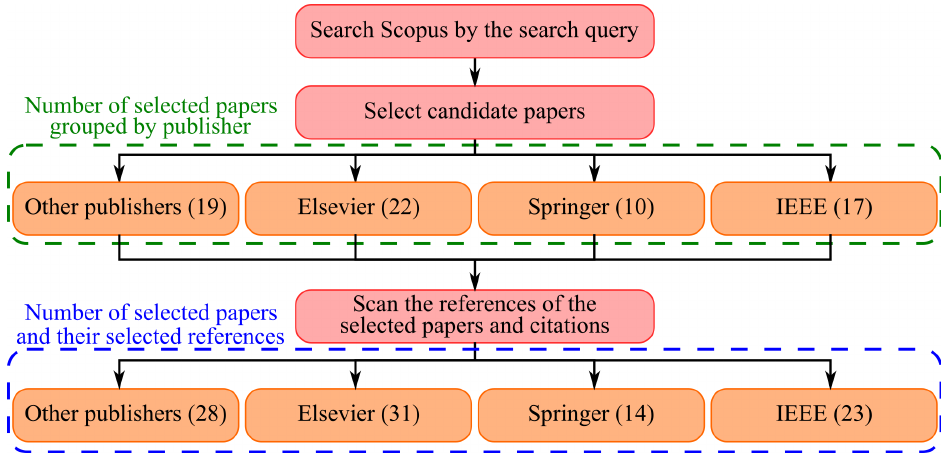
Figure 1. The number of reviewed